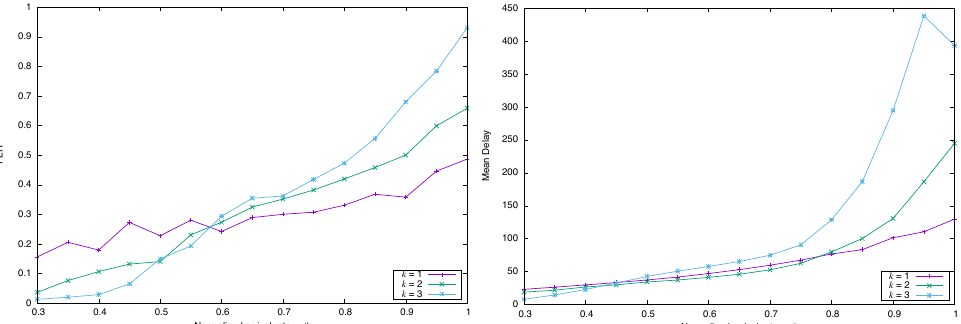
Figure 15. Simulated PLR ( left ) and Mean Delay ( right ) for FA-CSA versus λ a / k , with Λ ( x ) = 0.86 x 3 + 0.14 x 8 , n = 200 and k = { 1,2,3 } , and correlated arrivals ( H = 0.9 and r 1 = 0.5) with marginal Poissonian